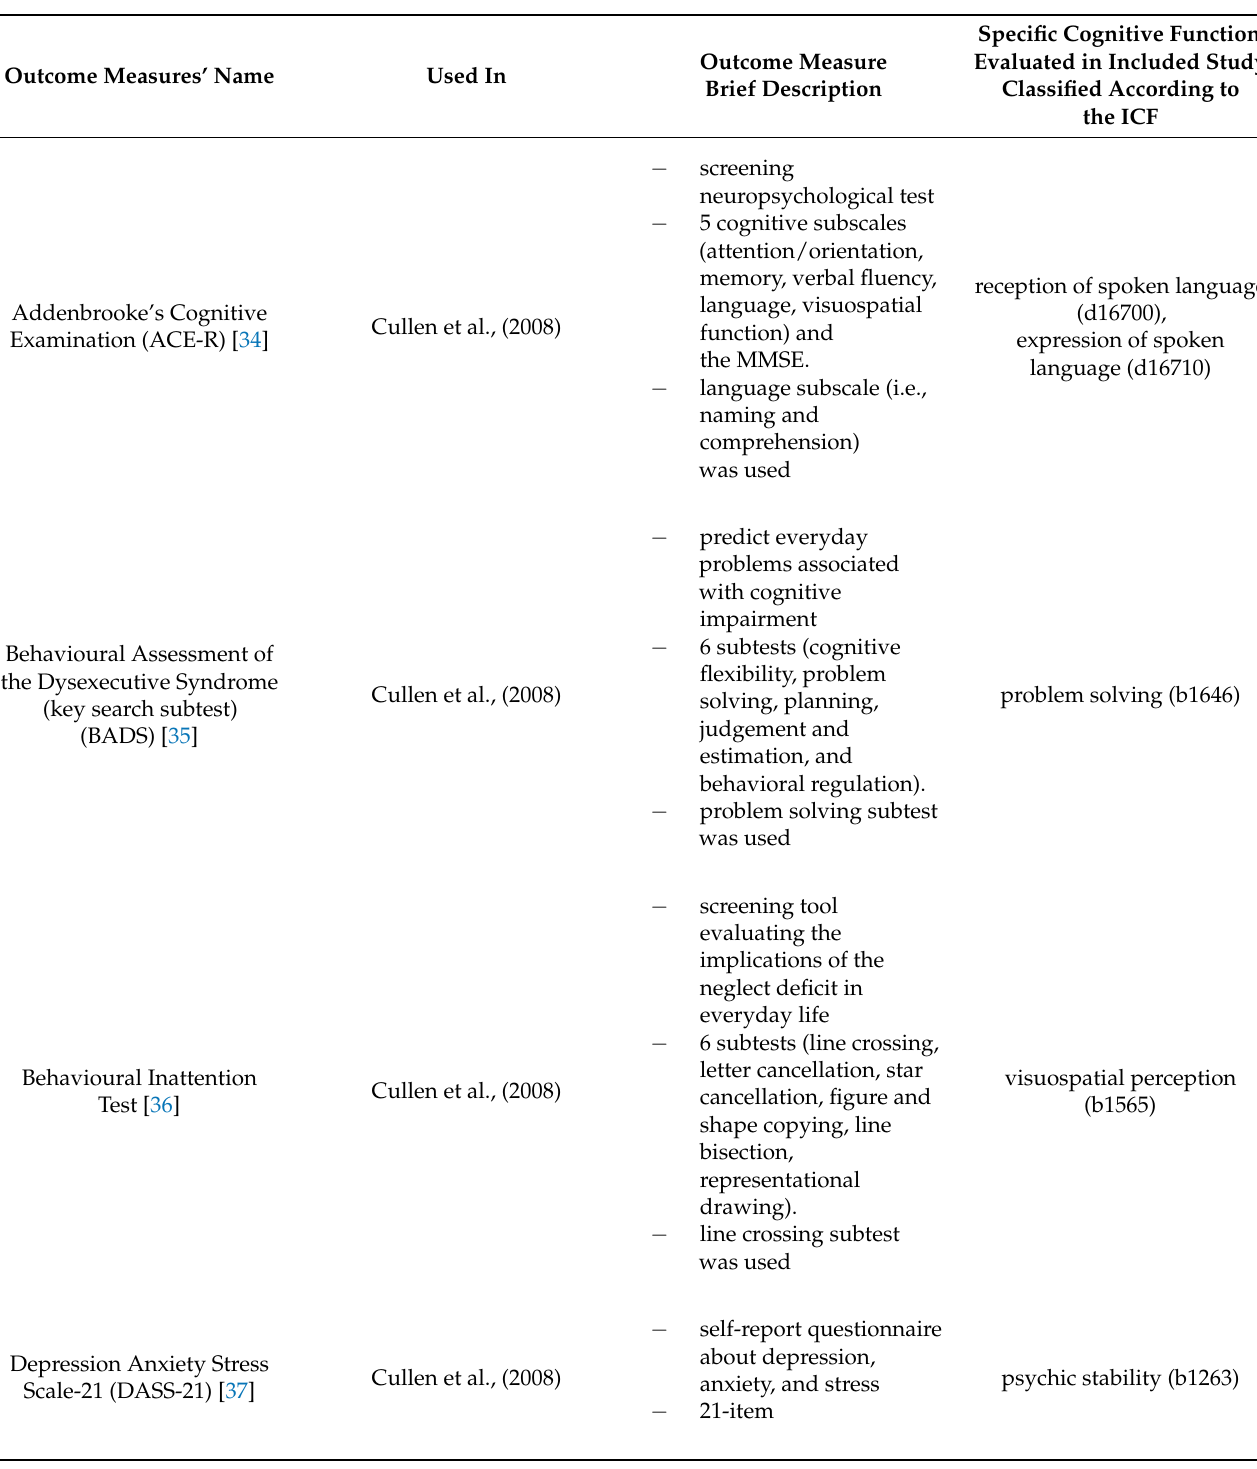
Table 2. Classification of outcome measures (and items) related to cognition used in the studies according to the International Classification of Functioning, Disability and Health